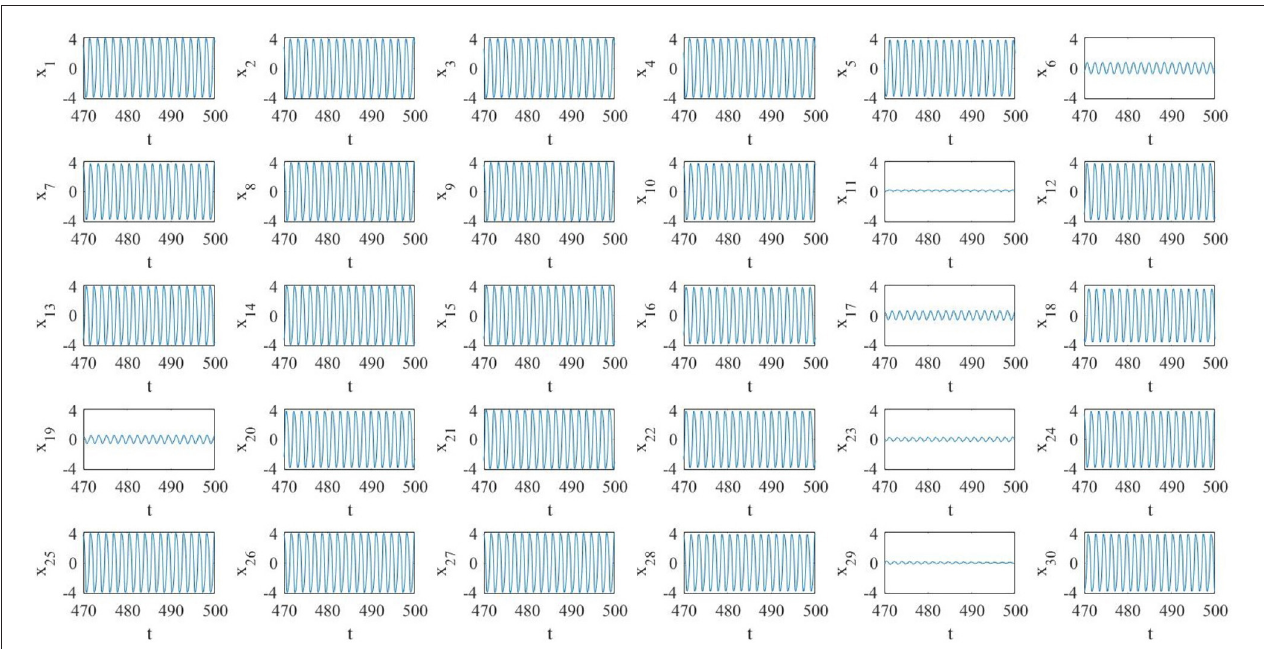
FIGURE 6 | Pristine diffusive network of N = 30 MOCs. Several oscillators (but not all) are on the large amplitude limit cycle.